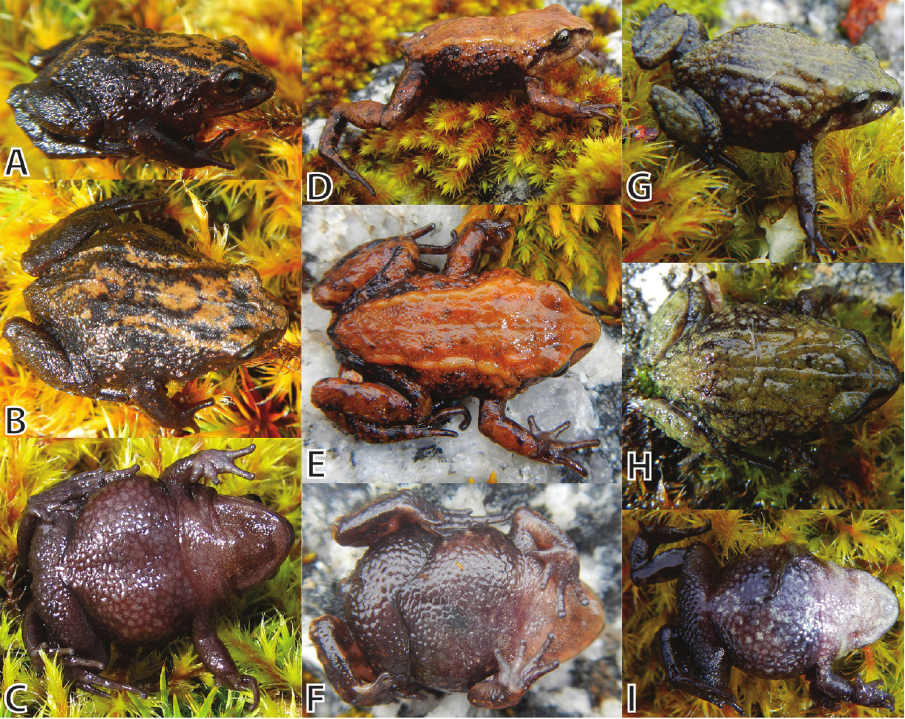
Figure 5. Variation of male paratypes of Pristimantis attenboroughi sp. n. in dorsolateral, dorsal, and ventral views. A–C (MUSM 31186, SVL 18.6 mm) D–F (MUSM 31195, SVL 16.9 mm) G–I (MUSM 31992, SVL 15.9 mm). Photos by E.